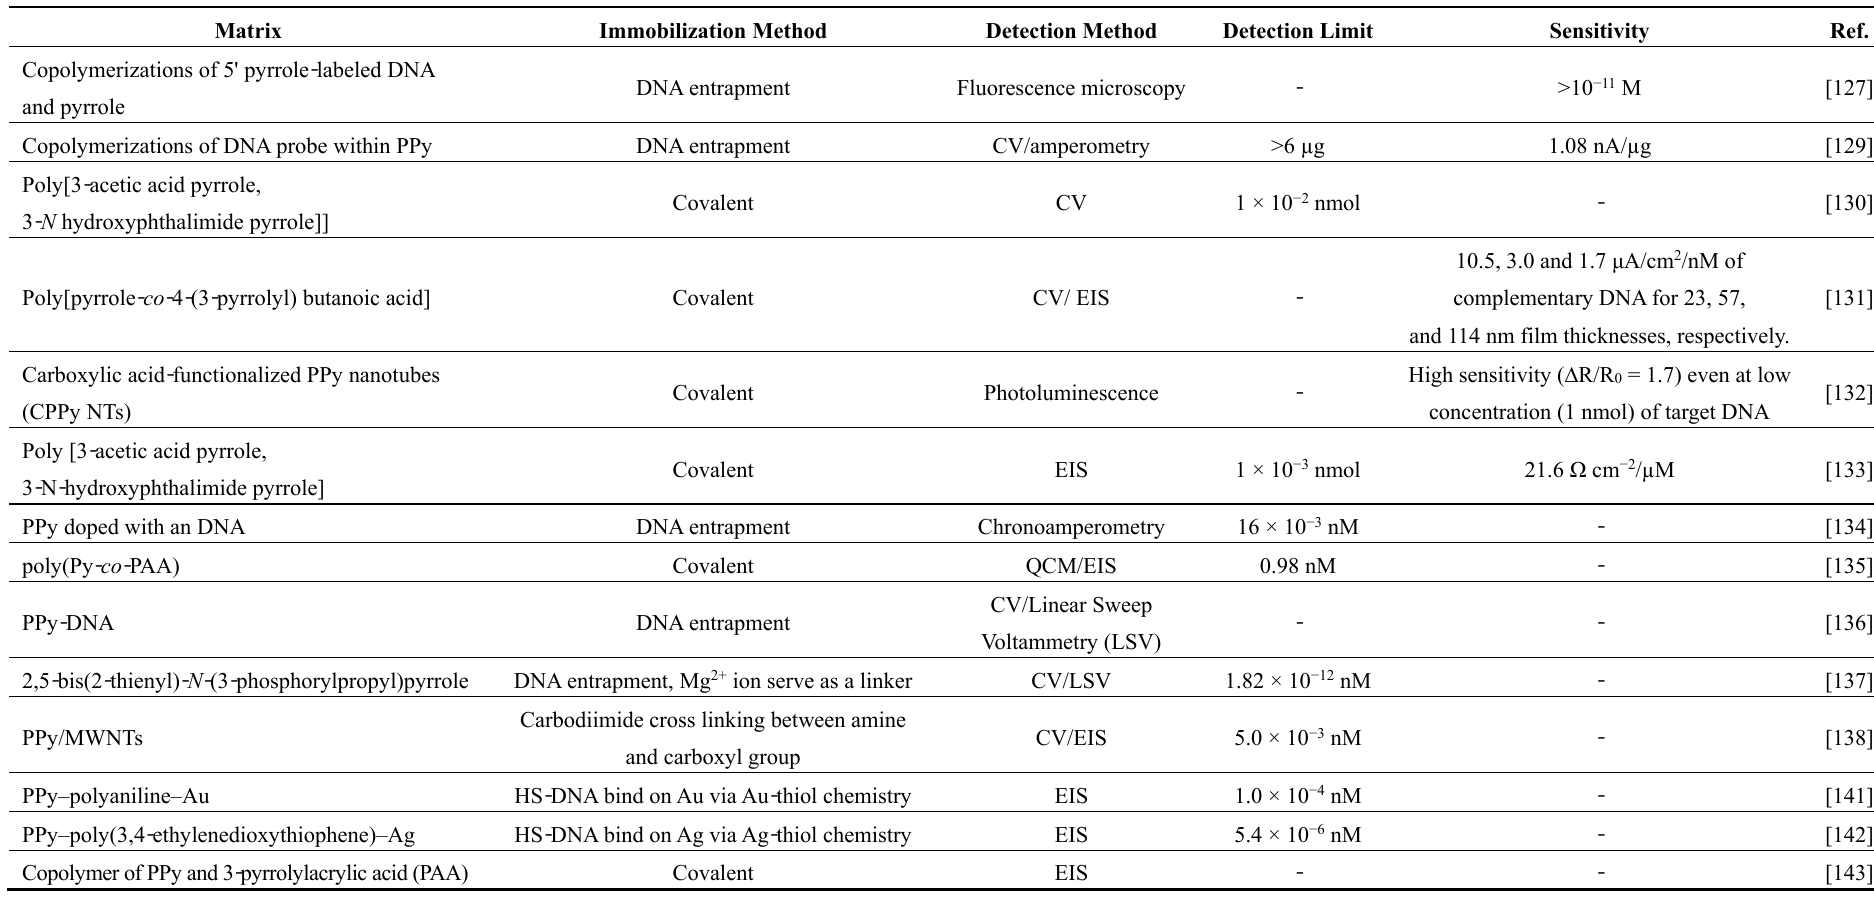
Table 1. DNA sensors based on Polypyrrole (PPy), PPy derivatives, and PPy composites and their performance in the detection of DNA